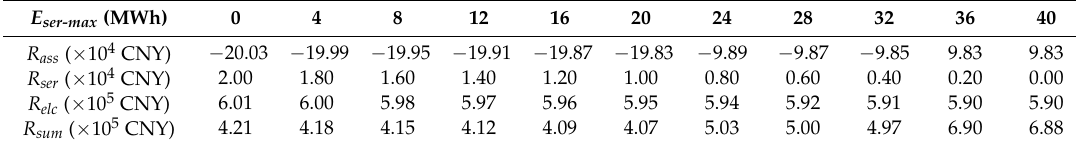
Table 7. The revenue of VPP of typical scenario 13.